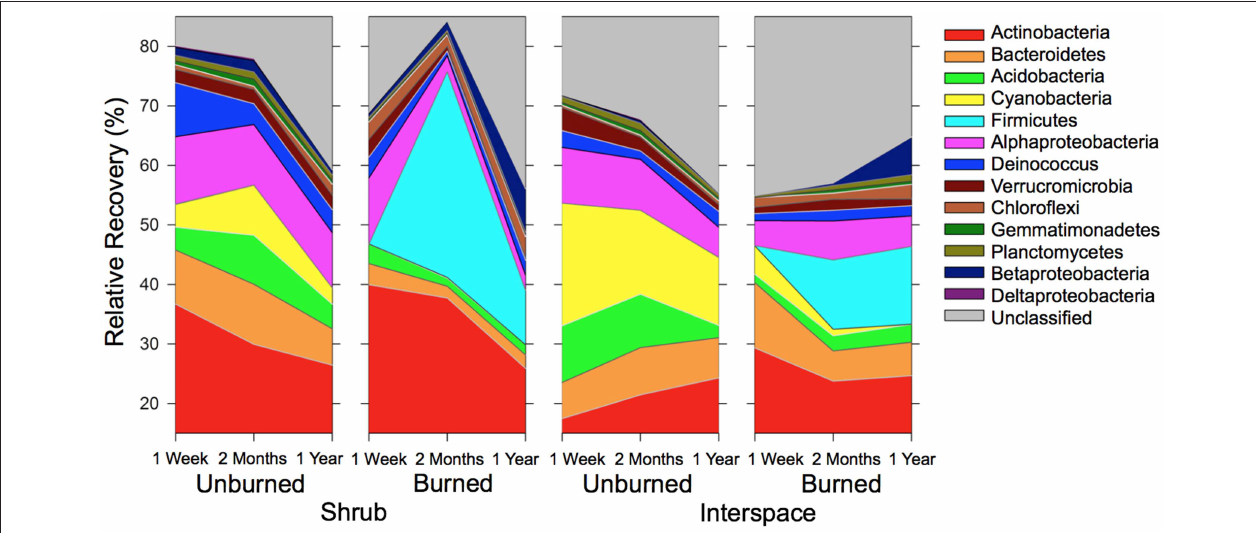
FIGURE 2 | Abundant Cyanobacteria were replaced by rare Firmicutes in burnt crusts. The distribution of OTUs (%) is presented for the 10 phyla and three Proteobacteria subclasses that contributed ≥ 1% to the total recovery of biocrust communities. Values are means ( n = 3) based on 16S rRNA gene libraries.